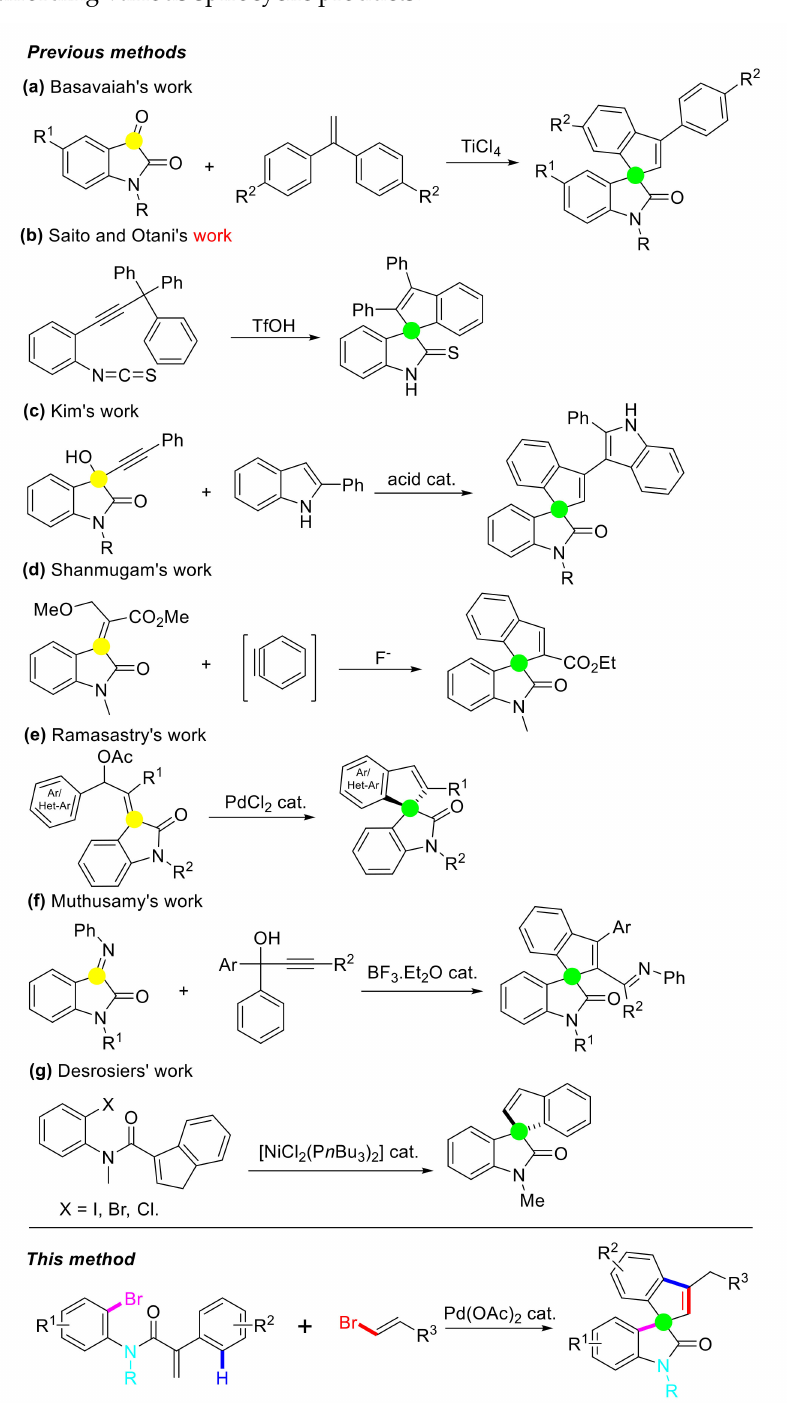
Figure 1. Synthetic methods of